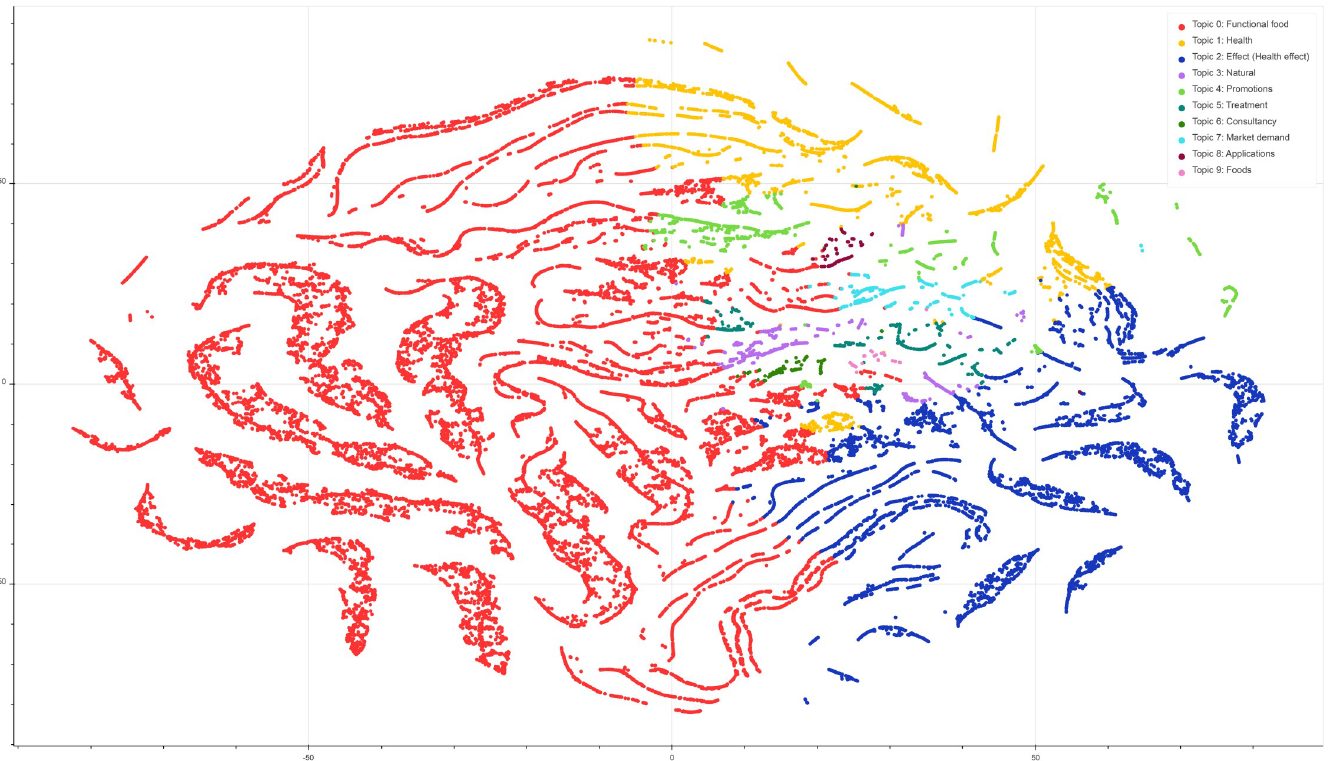
Fig 2. t-SNE plot illustrating the distribution of each tweet, and it’s dominant topic (colour). The plot denotes each topic using a colour, with each point being a document (tweet). The distances between each topic indicate the inter-topic distance. For instance, Topic 0 (Functional Food) is by far the largest and most dominant topic with the most tweets. It is also quite distinct from other topics in the array as most of the tweets are clustered together without other colours (topics) mixed in.